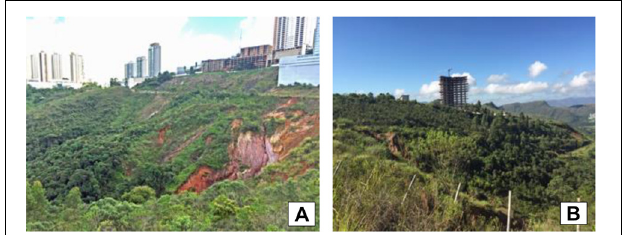
FIGURE 5 | Study area – gullies between Belvedere and Jardim da Torre neighborhoods. (A) Lateral view of erosive processes and buildings in the Belvedere neighborhood in the background, in Belo Horizonte; (B) another angle of the gully and view of a new residential real estate development in the neighborhood of “Jardim da Torre neighborhood,” Nova Lima. Source: Authors’ personal